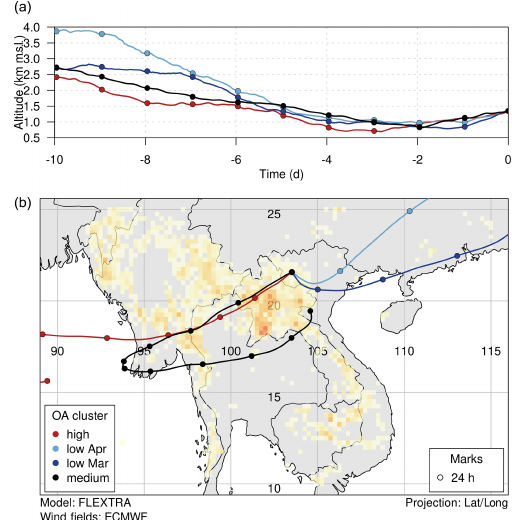
Figure 9. The 10-day backward trajectories arriving at PDI aver- aged for the periods determined by the organic aerosol clustering. The “low” class was additionally split into the period before the days with medium and high BB influence (March: low Mar) and after (April: low Apr). Panel (a) displays the average height of the trajectories above sea level on a relative time axis before arrival at the site. Panel (b) gives the average location of the trajectories over- laid on a map of MODIS fire count densities for the period spanning from 5d before until the end of the investigation period (from low (bright yellow) to high (orange-red) fire intensities). Filled circles on the trajectories mark a travel time of